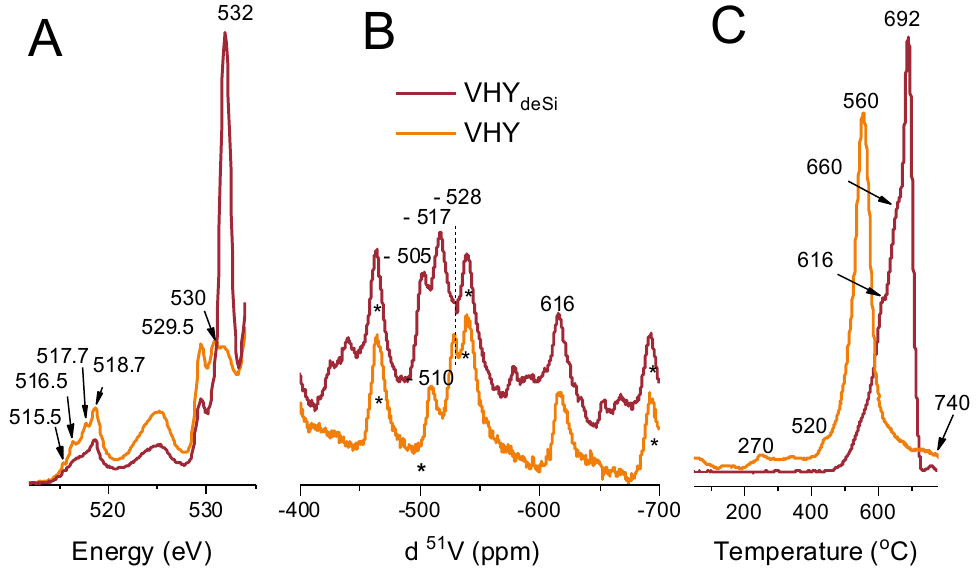
Figure 4. Partial fluorescence yield XAS spectra of V L 3,2 and O K edge regions for vanadium supported on zeolites studied ( A ). 51 V MAS NMR spectra ( B ). *—denotes spinning side bands. H 2 ‐ TPR profiles ( C ). H 2 -TPR profiles ( C